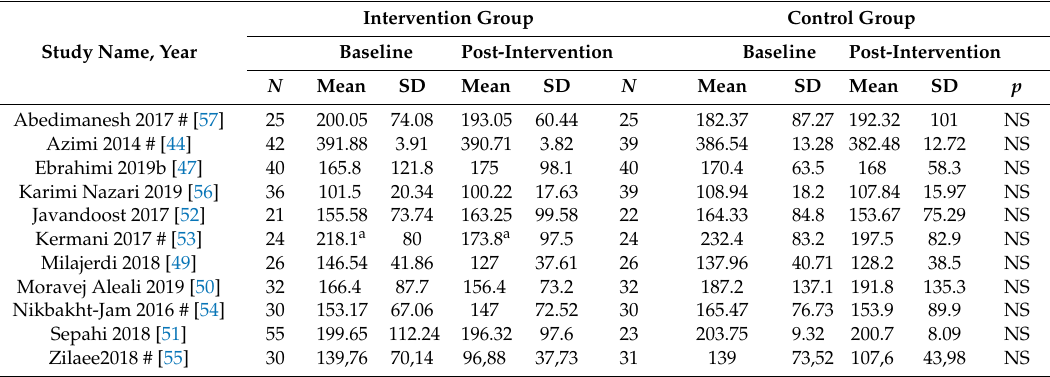
Table 7. Summary of findings for triglycerides (TG).